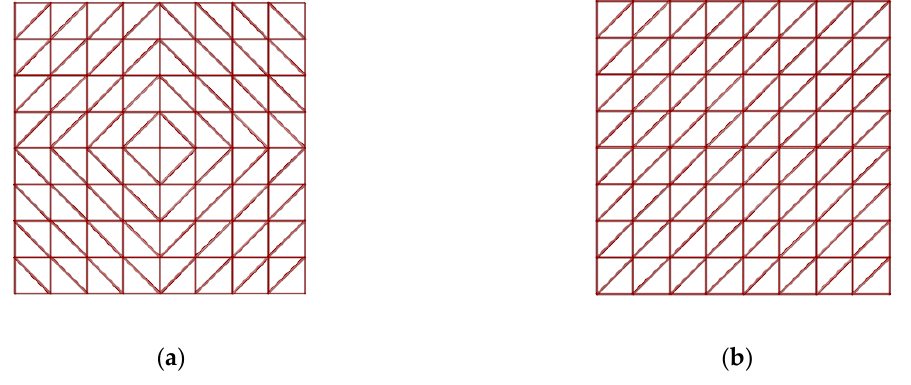
Figure 4. Rectangular projections of considered grid patterns: ( a ) the pattern—split along a short diagonal; ( b ) the pattern—split along a long diagonal.